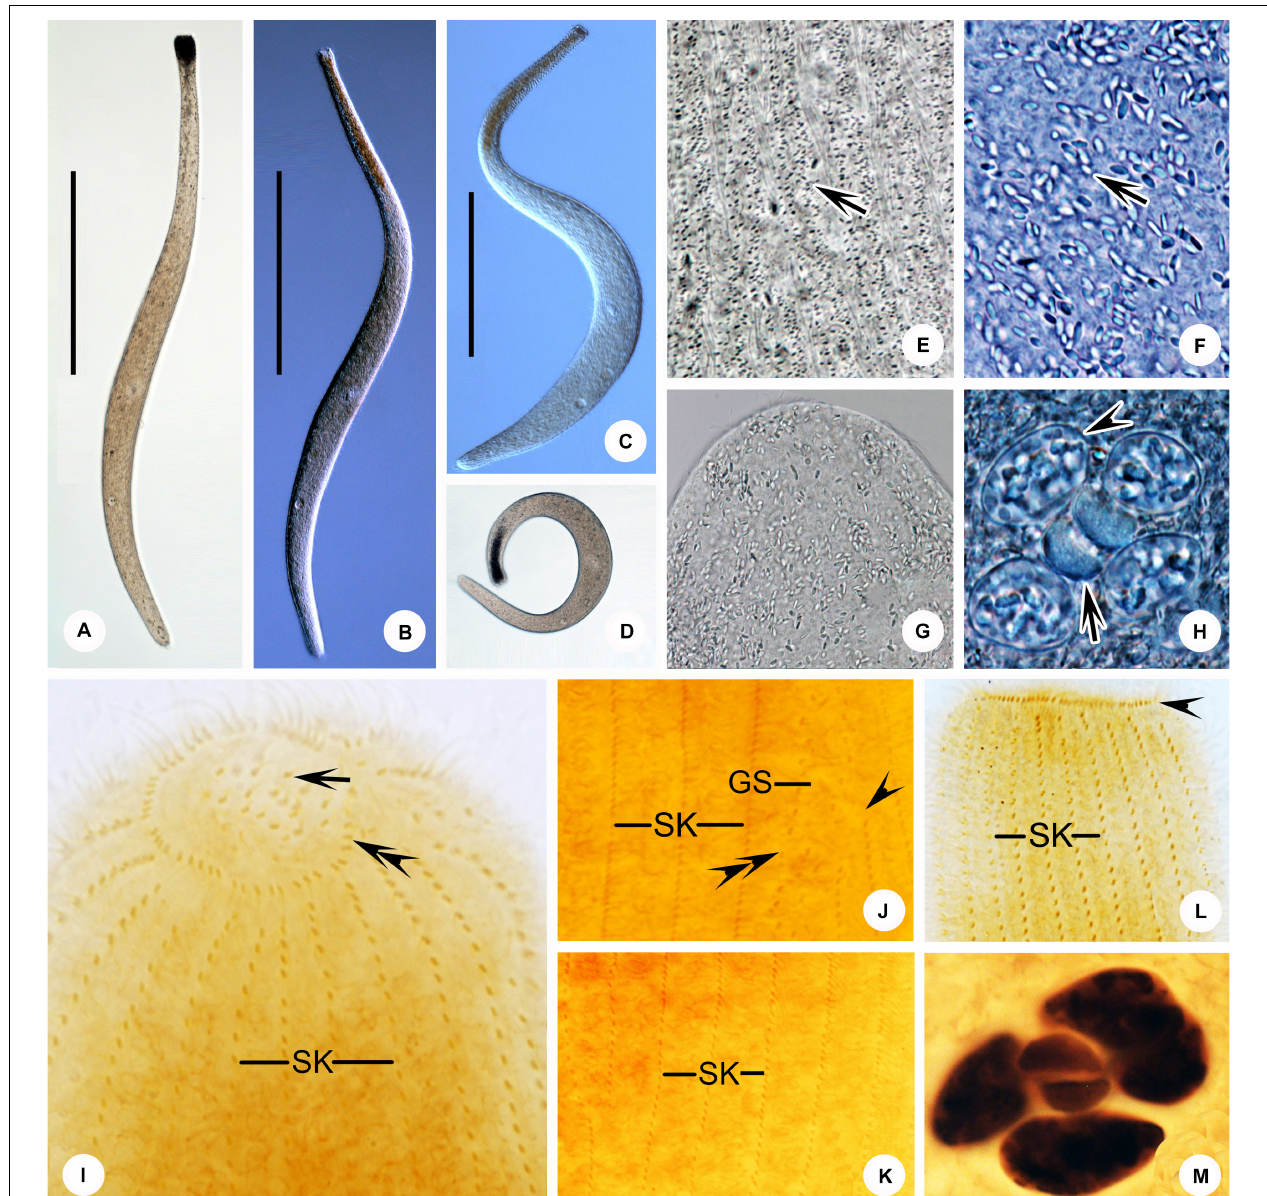
FIGURE 5 | (A–M) Trachelolophos monocaryon (Dragesco, 1965) comb. nov. in vivo (A–H) and after protargol staining (I–M) . (A–C) Typical individual. (D) An extremely curved cell. (E) Distribution of cortical granules (arrow) between somatic kineties. (F) Showing ellipsoidal granules (arrow). (G) Showing the head full of ellipsoidal granules. (H) Nuclear group, arrow showing micronuclei, arrowhead showing crystals in the macronuclei. (I) Anterior region of cell showing the ciliary tuft (arrow) and circumoral kinety (double arrowheads). (J) Detail of trunk showing the glabrous stripe with secant system on left side (arrowheads), bristle kinety (double arrowheads), and somatic kineties. (K) Showing the somatic kineties. (L) Anterior of cell. arrowhead shows circumoral kinety. (M) Nuclear group. GS, glabrous stripe; SK, somatic kineties. Scale bars = 300 µ m (A–C)